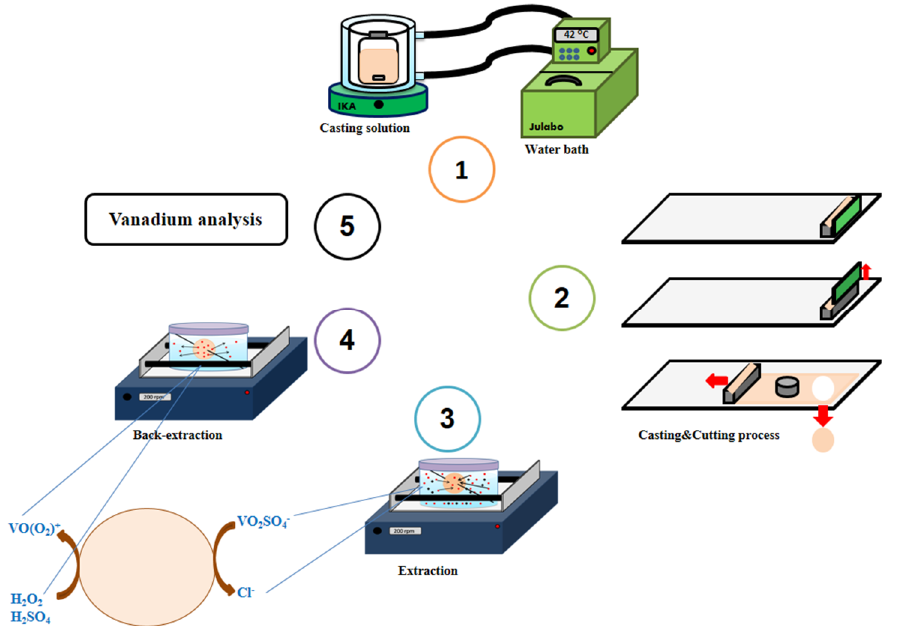
Figure 1. Schematic representation of the experimental procedure.